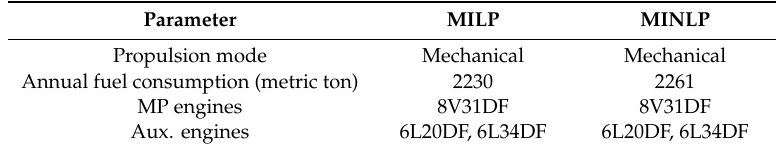
Table 5. Cargo ship: optimization results.